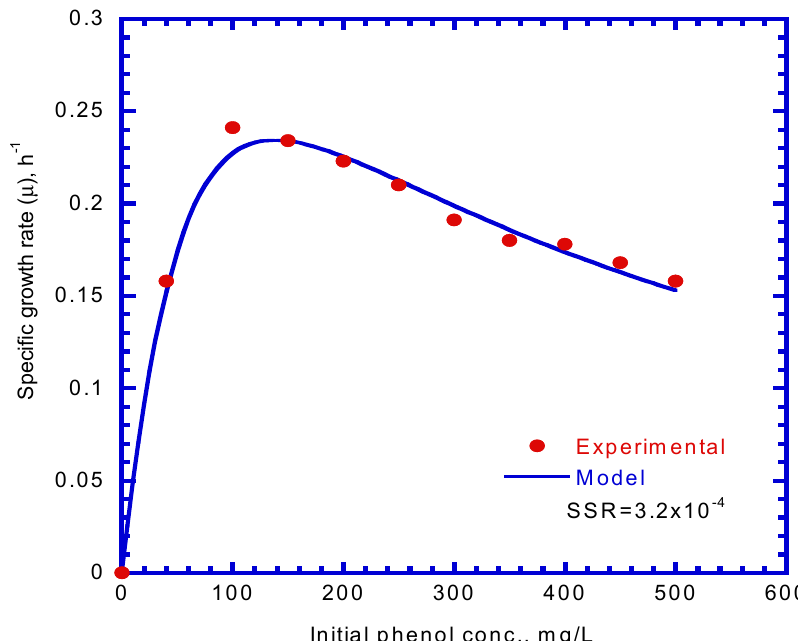
Figure 4. Specific growth rate versus initial phenol concentration, fitted by the Haldane model to determine the maximum specific growth rate on phenol ( µ m , P ), half-saturation constant for phenol ( K S , P ) and self-inhibition constant of phenol ( K I , P )